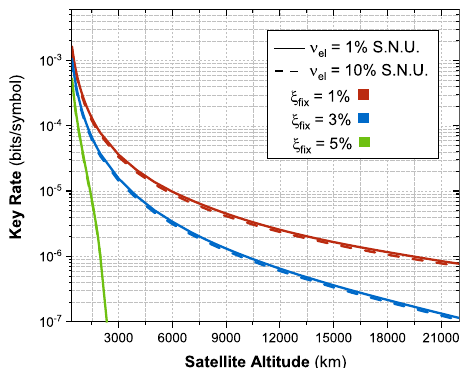
Fig. 8 Finite-size vs asymptotic key rate. Comparison of the key rate for LEO between the asymptotic regime (solid line) and considering fi nite-size effects (dashed line), which have been calculated for a symbol rate of 1 Gsymbol/s. The fi xed excess noise, ξ fi x , is 1% (red), 3% (blue) 5% (green).